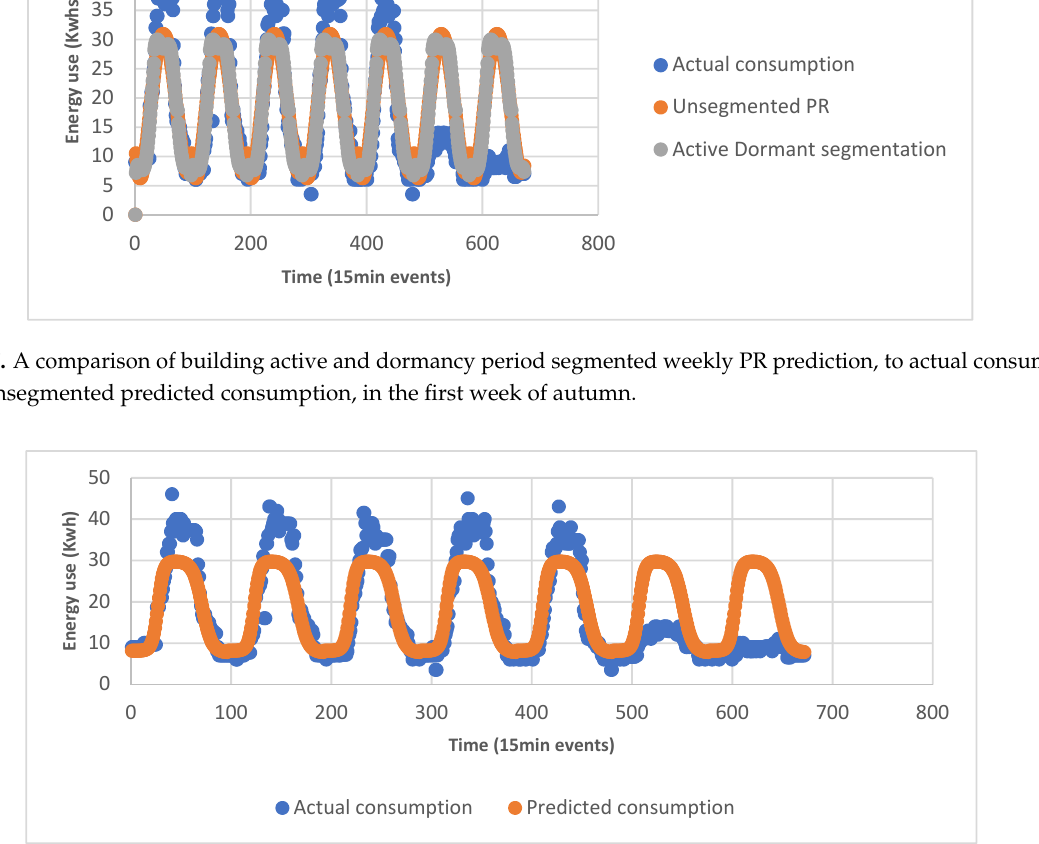
Figure A9. A comparison of weekday and weekend segmented weekly ANN predictions, to actual consumption and the unsegmented predicted consumption, in the first week of autumn. Figure A10. A comparison of building active and dormancy period segmented weekly ANN pre- diction, to actual consumption and the unsegmented predicted consumption, in the first week of autumn.